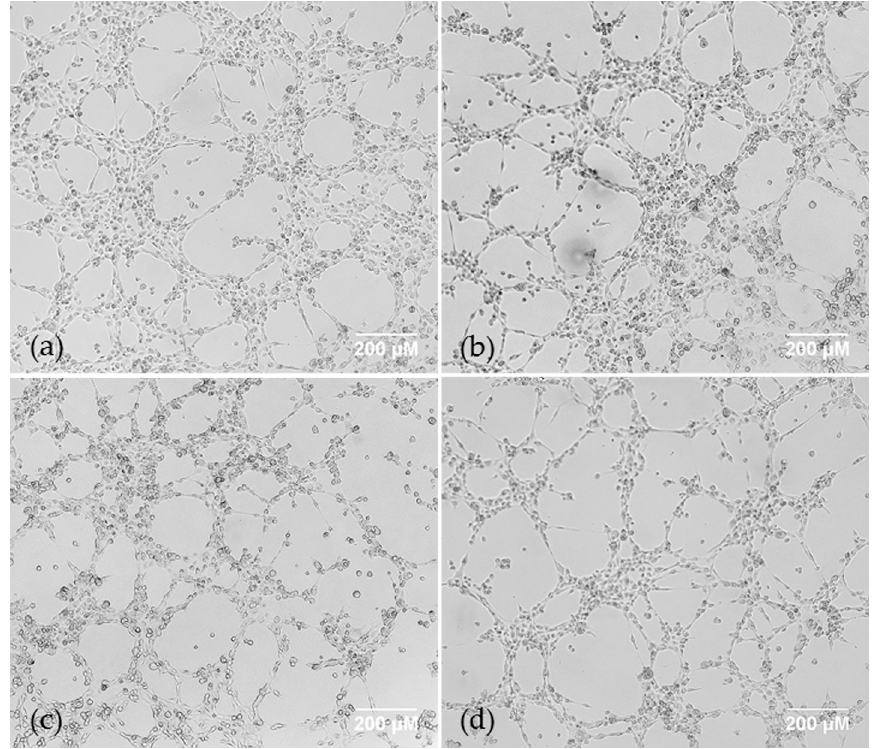
Figure 4. NCI-H226 cells in a Matrigel VM assay were treated with ( a ) DMSO control; ( b ) AQP1- specific siRNA alone; ( c ) bevacizumab alone; ( d ) a combination of AQP1-specific siRNA and bevacizumab. Treatment with 20 nM of AQP1 siRNA and 10 μ g/mL of bevacizumab in combination or alone does not inhibit vasculogenic mimicry in NCI-H226 cells under normoxic